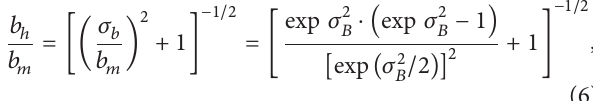
Figure 2: Change of the water-cement ratio after the cement particles